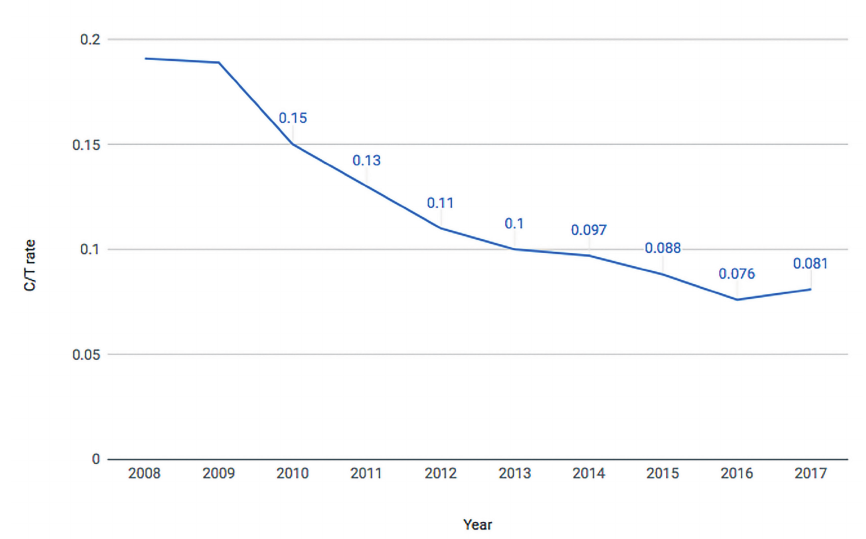
Figure 6 - Cystectomy over TURb Rate from 2008 –